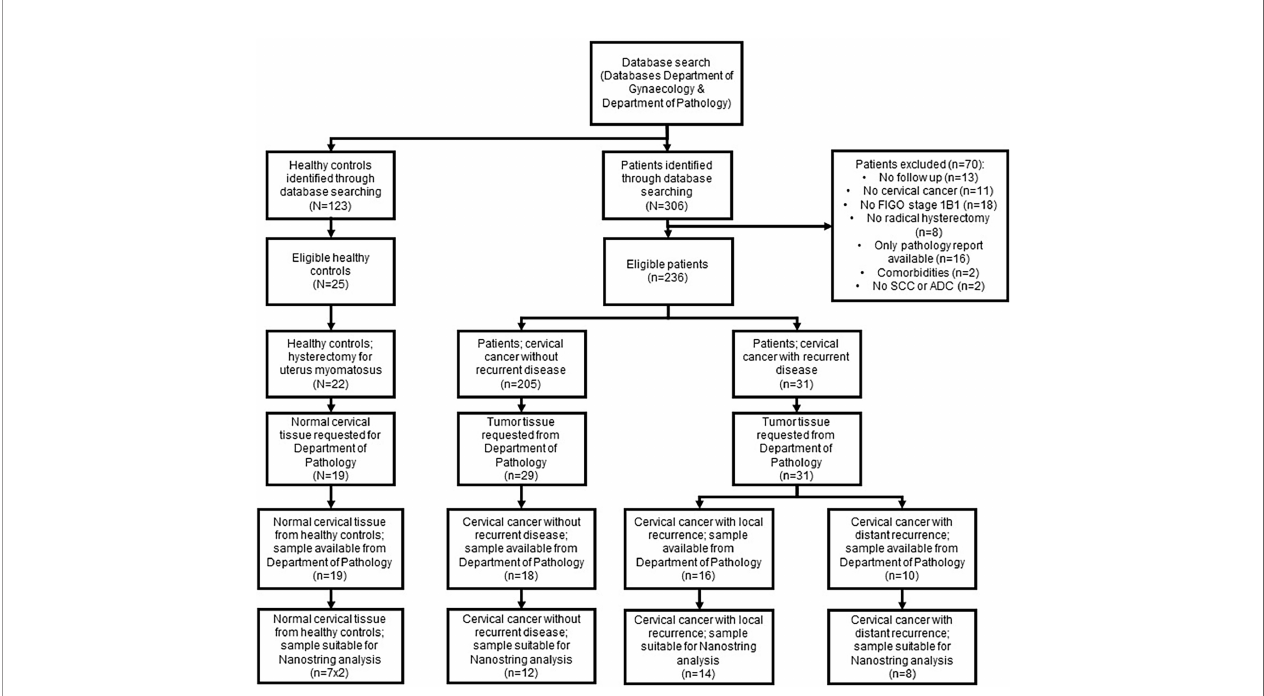
FIGURE 1 | Flowchart patient samples. Flowchart demonstrating the number of patients samples included in the study and the excluded samples with the